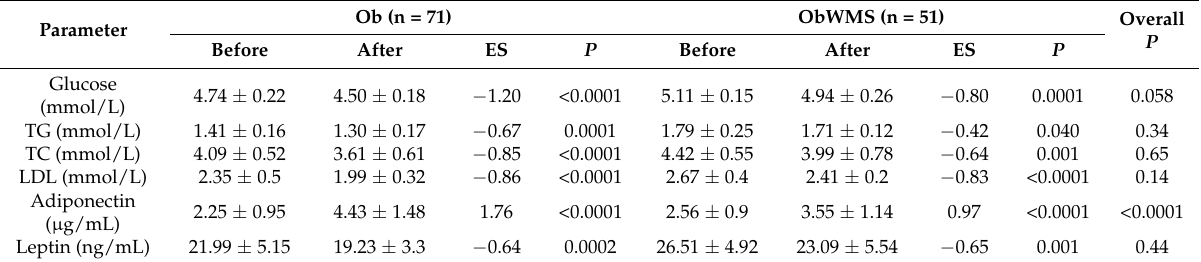
Table 2. Mean values and standard deviations (SD) of blood biomarkers and adipokines before and after the training program.